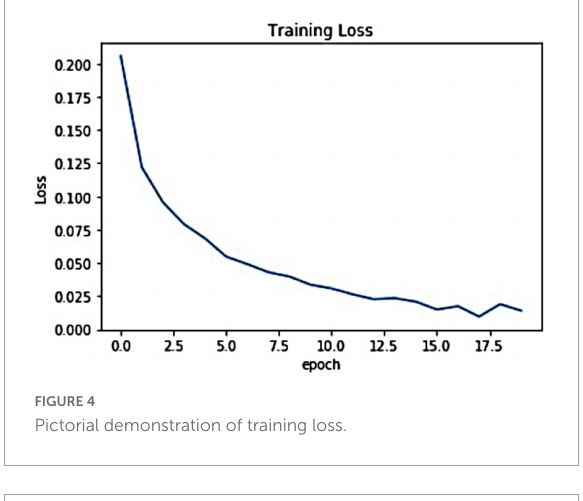
TABLE 2 Details of network hyperparameters.